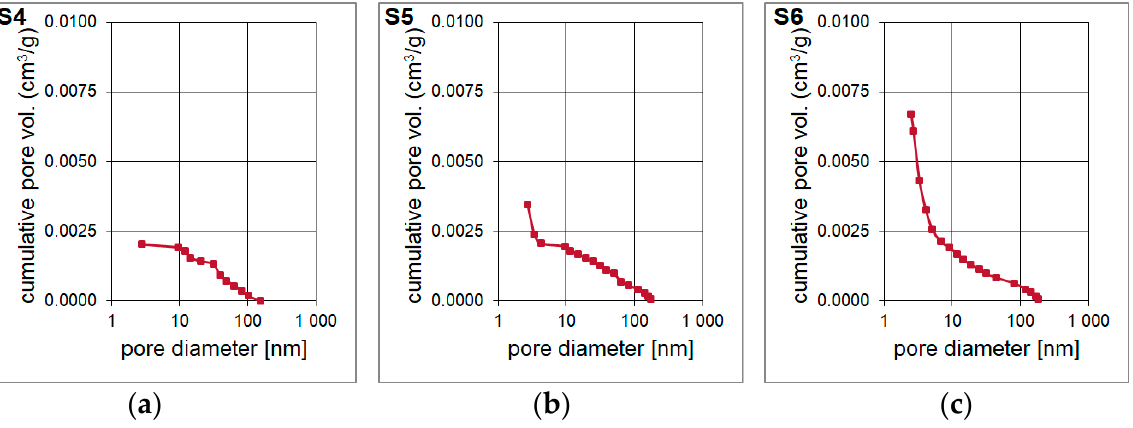
Figure 6. ( a – c ) Pore volume of the porous silicon oxycarbide materials, abbreviation: vol.—volume.